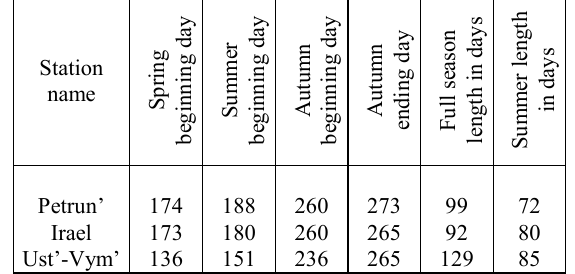
Table 1. Framing dates and lengths of growing seasons in 2018 detected at positions of meteorological stations using NDWI NDWI maps were masked to exclude water bodies from computations. Growing seasons were detected basing on NDWI values averaged in 10 km window around every meteorological station. The window size was selected accordingly to the recommendations of World Meteorological Organization